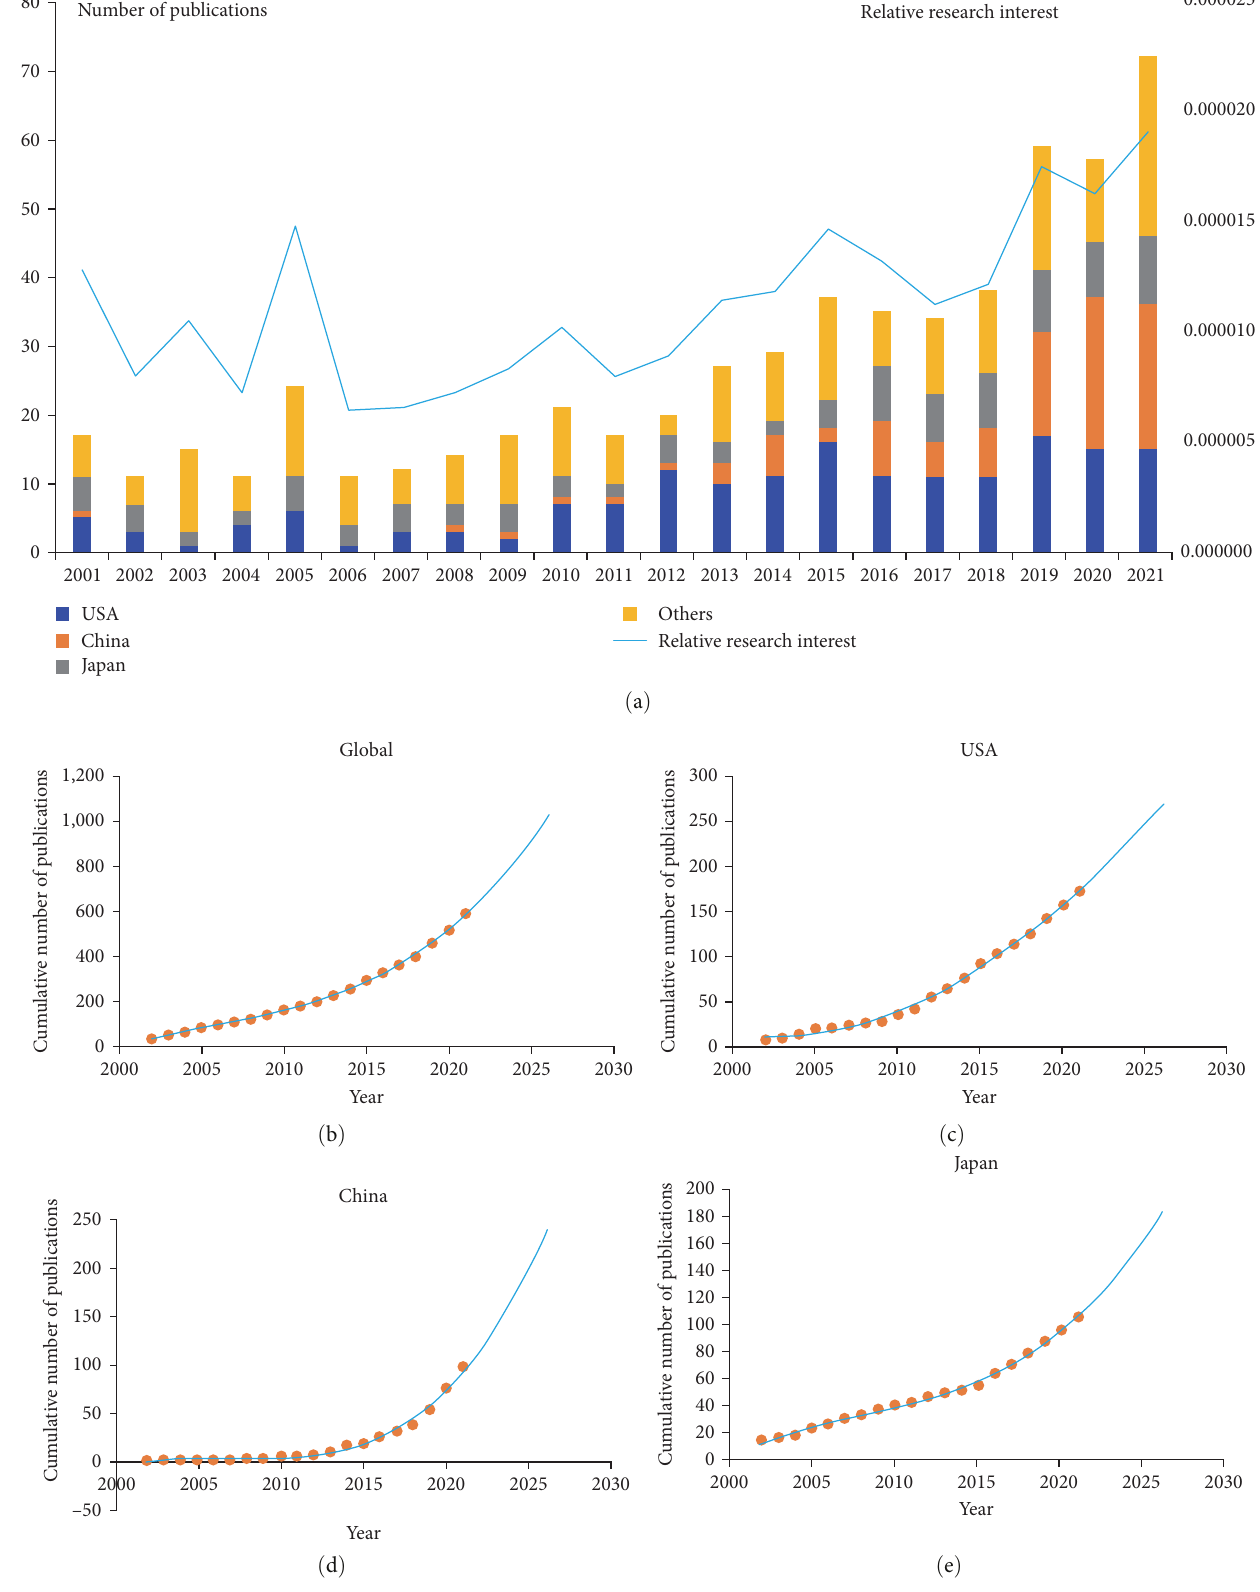
F IGURE 2: Global growth trends of publications on IPF and immune response. (a) Bar chart showing the number of publications per year for the world and the top three countries; the timeline of relative research interest in IPF and immune response ( ∗ means “ × ” ). (b) A model fi tting curve of growth trends across the globe, United States (c), China (d), and Japan